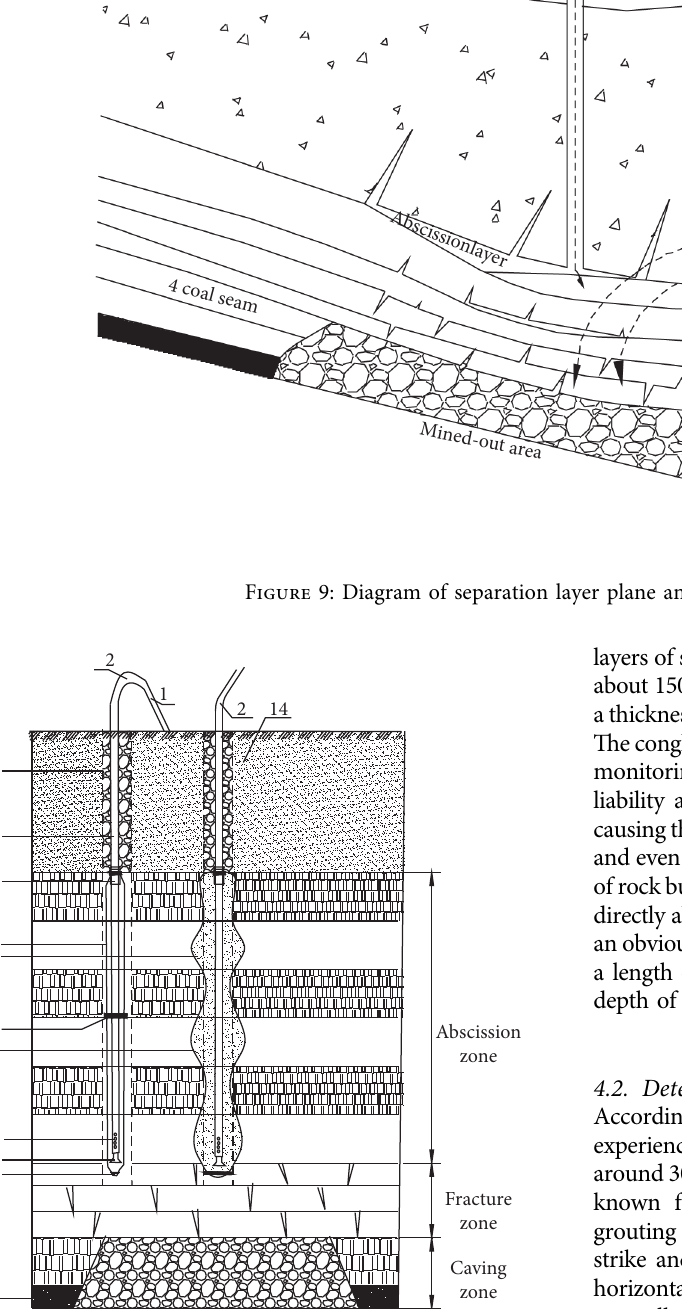
Figure 10: Pocket layer reinforcing process. In the figure, the numbers represent the following parts: (1) high-pressure hose, (2) grouting pipe bend, (3) the grouting hole, (4) grouting steel pipe, (5) plastic ring, (6) nylon pouch, (7) material slurry, (8) the rubber aprons, (9) pocket inflation, (10) perforated grouting pipe, (11) rubber plug, (12) wire head, (13) coal seam, and (14) surface soil